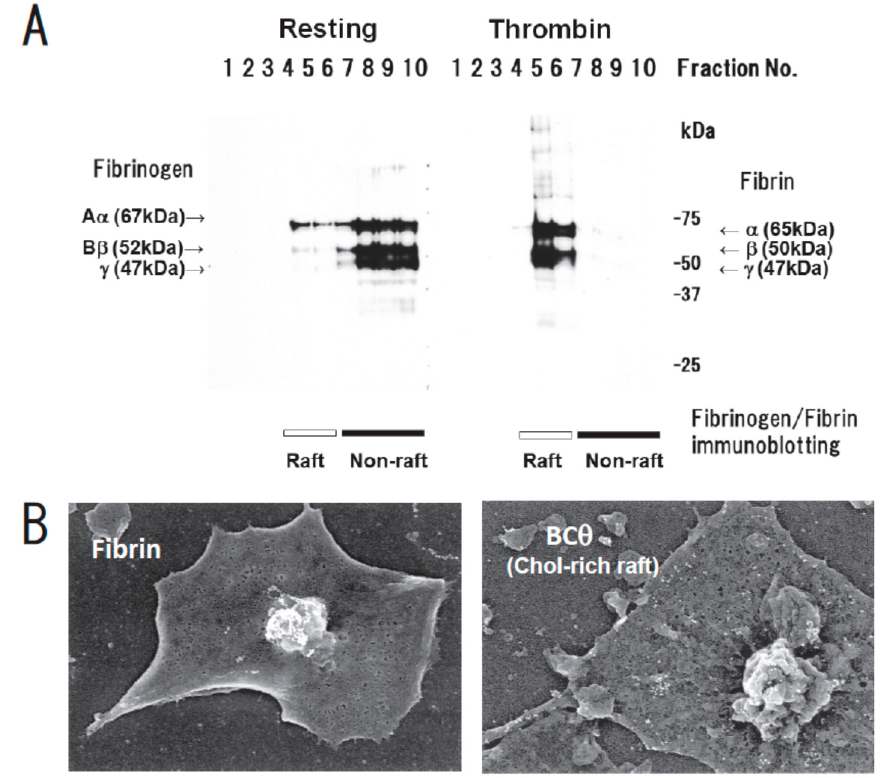
Figure 1. Fibrin translocation to lipid rafts in central region of spreading platelets stimulated with thrombin. ( A ) Sucrose density gradient analysis of washed human platelets. Resting platelets (left) and platelets stimulated for 3 min with 1 U / mL thrombin (right) were lysed in Triton X-100 and then adjusted to 40% sucrose. A sucrose gradient (5–30%) in a volume of 6 mL was layered over the lysate (4 mL) and was centrifuged. Ten fractions were collected from top to bottom after centrifugation and subjected to immunoblotting with an anti-fibrinogen polyclonal antibody. In resting platelets, fibrinogens A α (67 kDa), B β (52 kDa), and γ (47 kDa) were detected in the non-raft fraction (lanes 7–10). In contrast, fibrins α (65 kDa), β (50 kDa), and γ (47 kDa) were detected in the raft fraction (lanes 5,6) of thrombin-stimulated platelets. ( B ) Localization of fibrin ( left panel ) and BC θ -positive cholesterol-rich rafts ( right panel ) of thrombin-stimulated spreading platelets on fibronectin by scanning immunoelectron microscopy. Spreading platelets were incubated with 15 μ g/mL BC θ for 30 min followed by glutaraldehyde fixation and immunolabeling with anti-biotin IgG gold. Gold-positive fibrins were localized in the central region of spreading platelet ( left ). In contrast, gold-positive cholesterol-rich rafts were localized uniformly on the membrane ( right ). The study was approved by the institutional ethics committee.